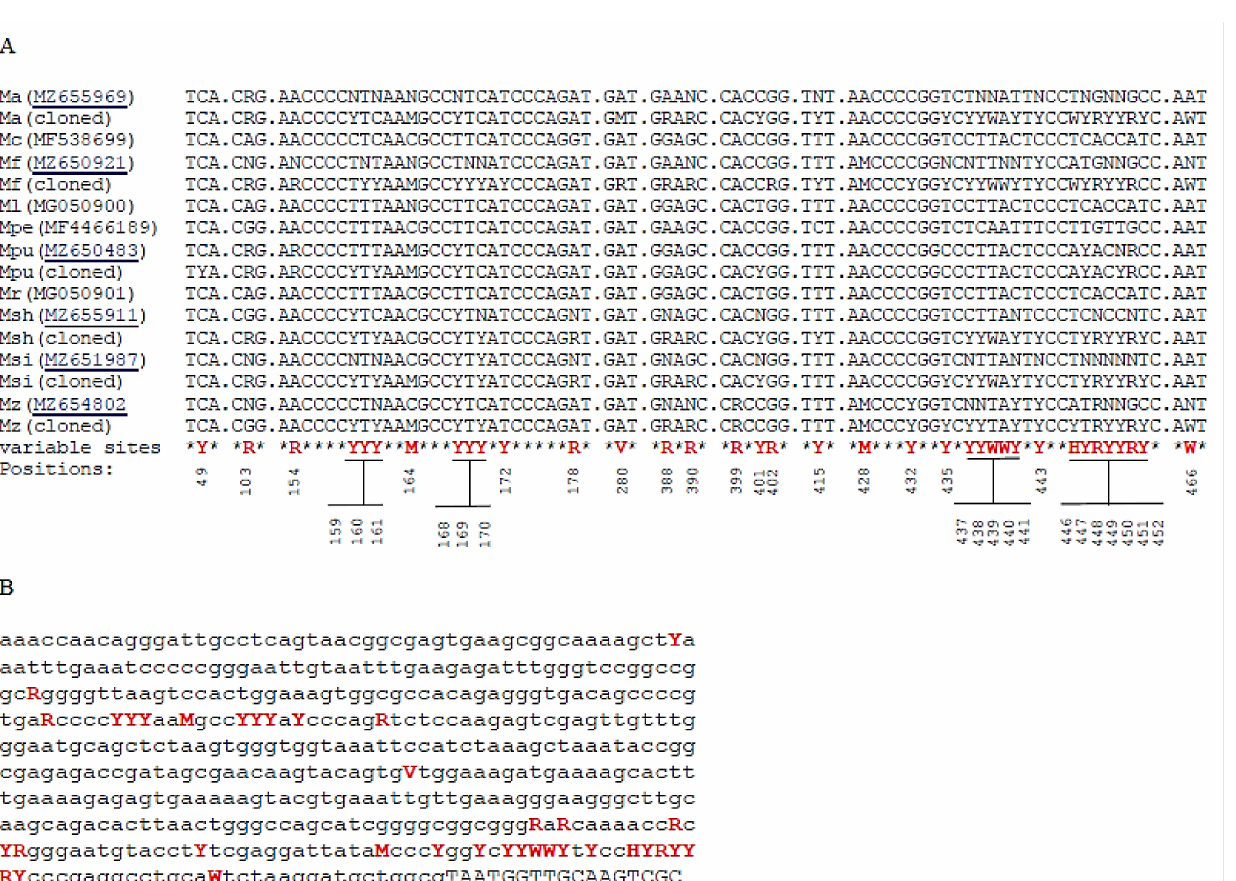
Figure 4. Comparison of the D1/D2 sequences of the pulcherrima clade. ( A ) Multiple alignment of variable segments. Only examples of the database type-strain sequences are shown (GenBank accession numbers are given in parentheses). The cloned sequences are consensus sequences of clones. Numbering of the positions corresponds to that of the M. pulcherrima sequence NG_075437. Ma: M. andauensis ; Mc: M. citriensis ; Mf: M. fructicola ; Ml: M. leonuri ; Mpe: M. persimmonesis ; Mpu: M. pulcherrima ; Mr: M. rubicola ; Msh: M. shanxiensis ; Msi: M. sinensis ; Mz: M. zizyphicola ; M: A or C; R: A or G; Y: C or T; V: A or C or G; W: A or T. ( B ) Consensus sequence of the entire D1/D1 domain. Variable positions are highlighted with red